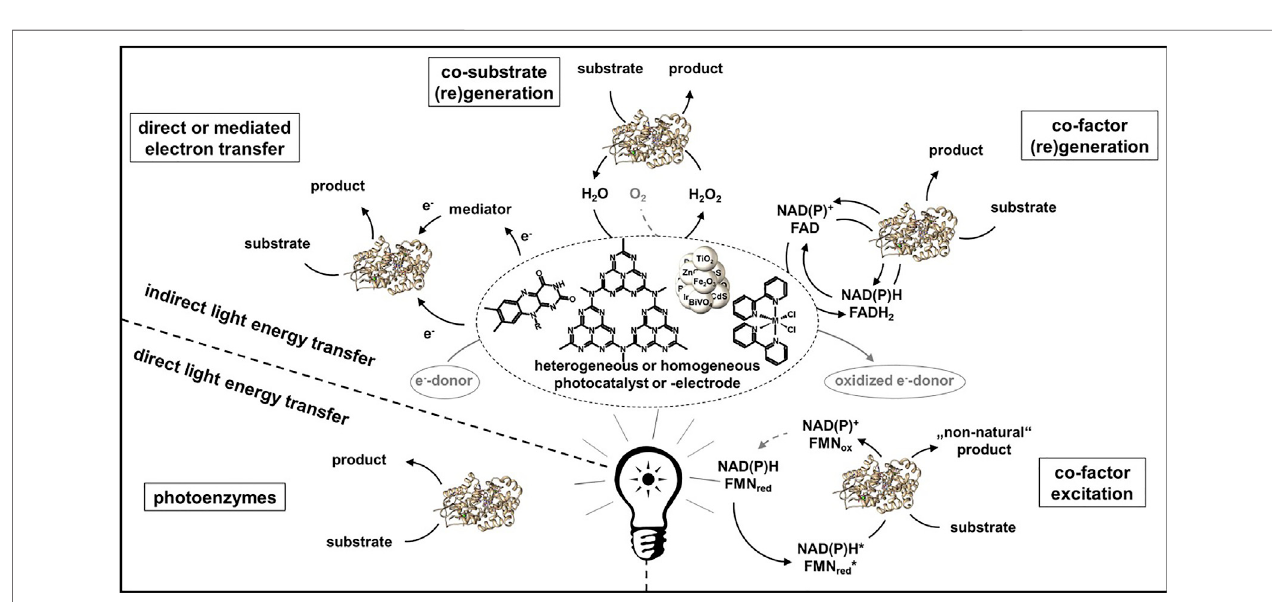
Frontiers in Catalysis |